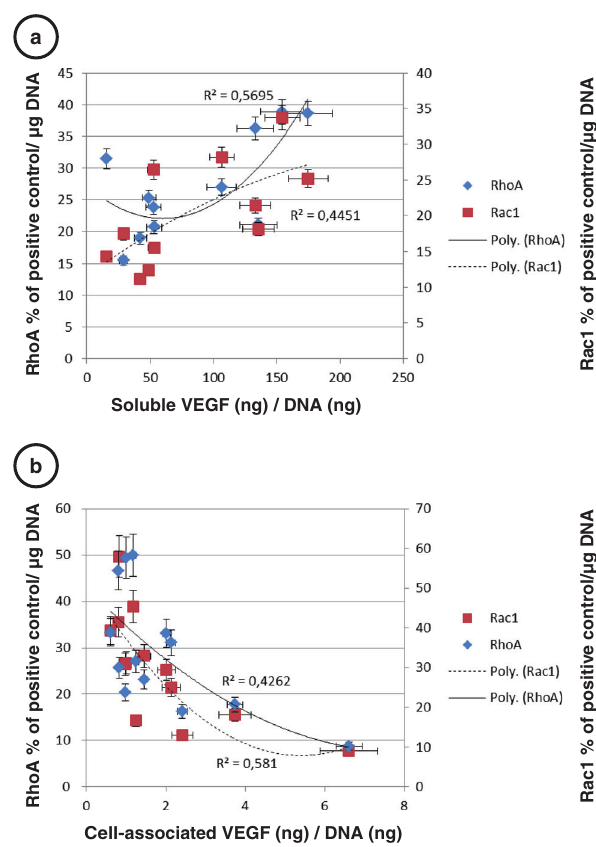
Fig. 7 Spearman ’ s rank correlations with signi fi cant associations for VEGF and RhoA and Rac1 activities . a Soluble VEGF secretion was associated with increased RhoA and Rac1 activities, p < 0.05. b Cell- associated VEGF (trapped VEGF) was negatively associated with RhoA and Rac1 activities, p < 0.05. Error bars represent S.E.M. ( N = 3 independent experiments)